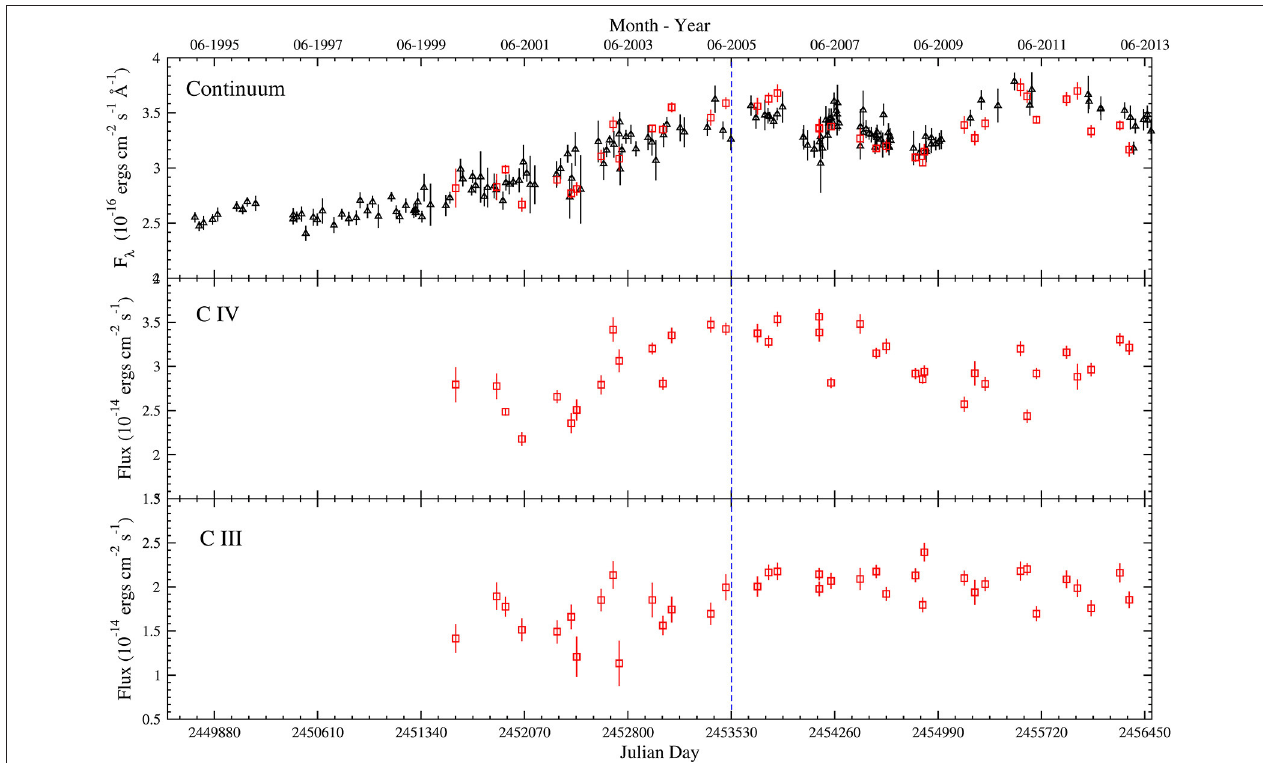
FIGURE 1 | Light curves for SBS1116 + 603. Red squares are points measured from the spectroscopic data and black triangles are points measured from the photometric data. The top panel is the continuum light curve (spectroscopic points measured on the red side of the C III ] line). The middle panel and lower panel are line light curves for C IV and C III ], respectively. Data up to the blue vertical dashed line were published in Kaspi et al.